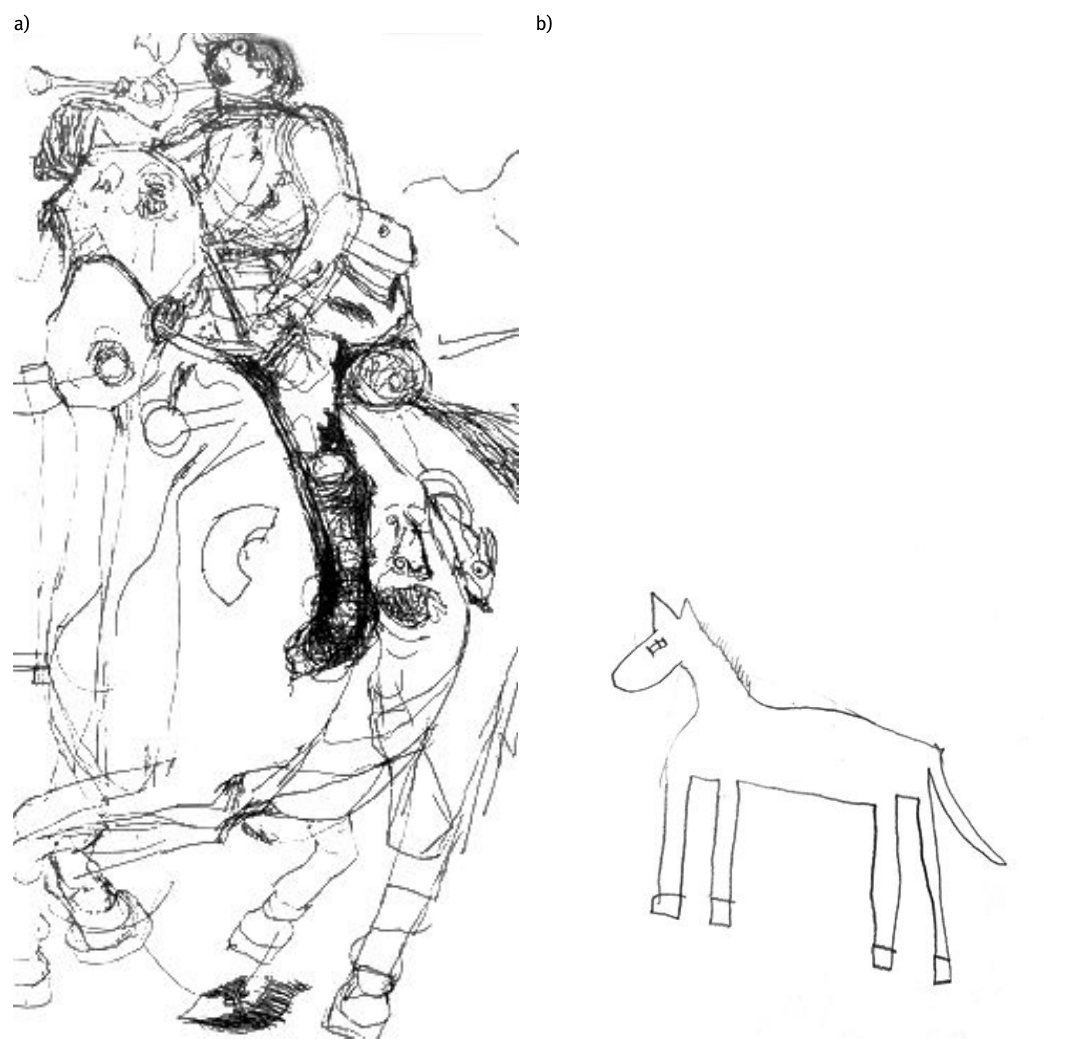
Figure 6. Drawing of a horse by Nadia (A) and by a typically developing child of the same age (B)